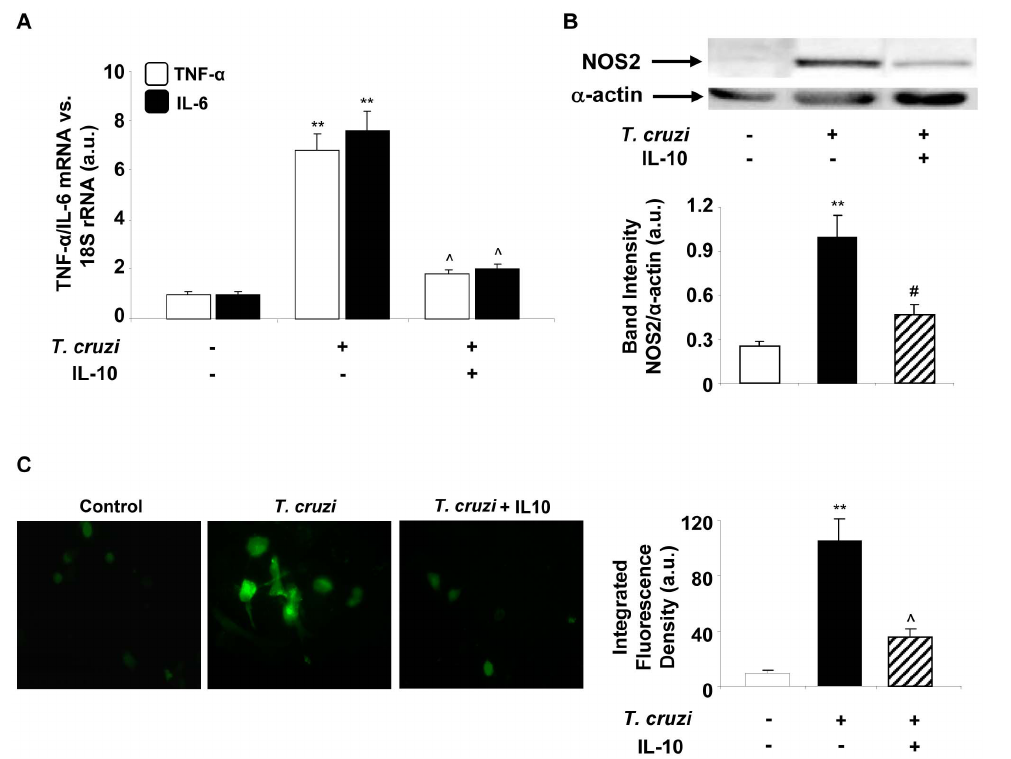
Figure 4. IL-10 treatment inhibits pro-inflammatory cytokines and NOS2 expression and activity in T.cruzi infected cardiomyocytes. (A) Cells were infected with T. cruzi or pre-treated with IL-10 (20 ng/ml) and TNF- a and IL-6 mRNA levels were analysed by Q-RT-PCR 4 h post infection. (B) NOS2 expression was analysed by Wb in total protein extracts obtained after 48 h of T. cruzi infection or after pre-treatment with IL-10. (C) Cells were grown on round glass cover slips and infected with T. cruzi or pre-treated with 20 ng/ml of IL-10 for 15 min. After 48 h of infection, NO synthesis was detected in situ by the NO indicator DAF-FM and visualized by fluorescence microscopy. For A, results were normalized against 18S and represent the mean 6 SD of three independent experiments. For B, results show the mean 6 SD (n=4) and protein levels were normalized against a - actin. In C, microphotographs (400X) are representative of three independent experiments performed. The graph represents the mean 6 SD of the integrated fluorescence densities. **p , 0.01 vs. control cells;ˆp , 0.01 vs. T. cruzi infected cells; # p , 0.05 vs. T. cruzi infected cells.